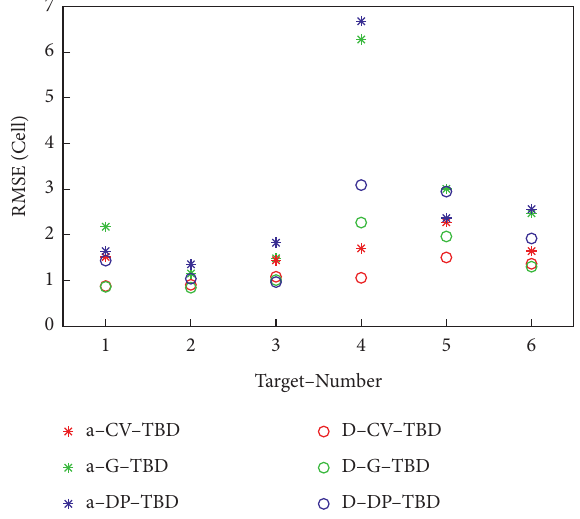
Figure 19: RMSE of 6 targets’